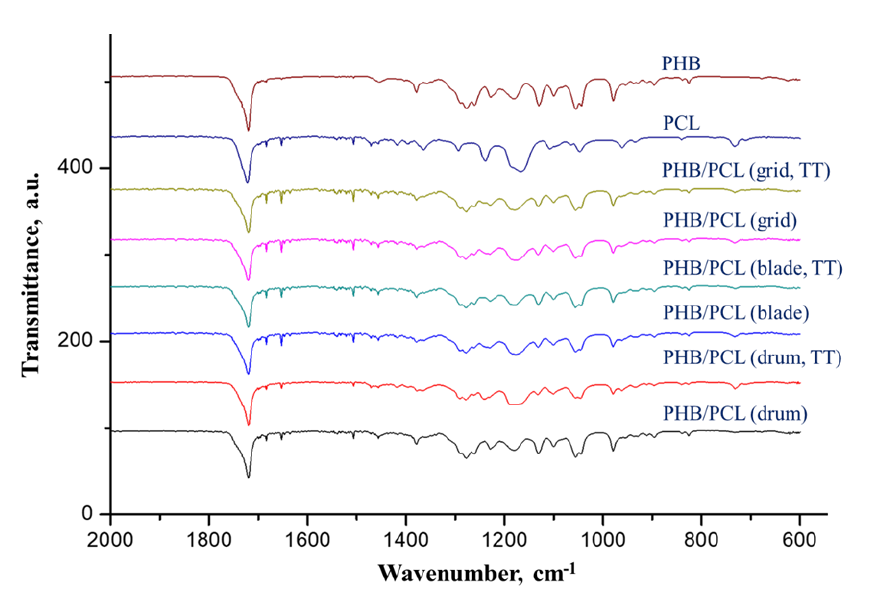
Figure 5. SEM micrographs of the internal surface in direction to the collector of the PHB/PCL mats before ( A–C ) and after ( D–F ) thermal treatment onto rotating drum ( A,D ), blade ( B,E ) and grid (C,F ) collectors. The direction of the collector rotation is indicated by arrows.